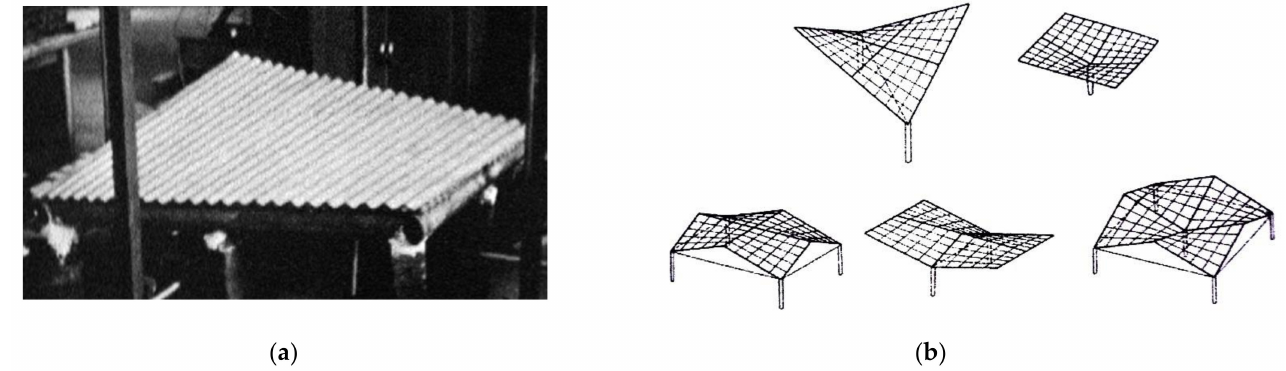
Figure 4. Two symmetric experimental hyperbolic paraboloid shells: ( a ) a complete shell; ( b ) umbrella structures of four